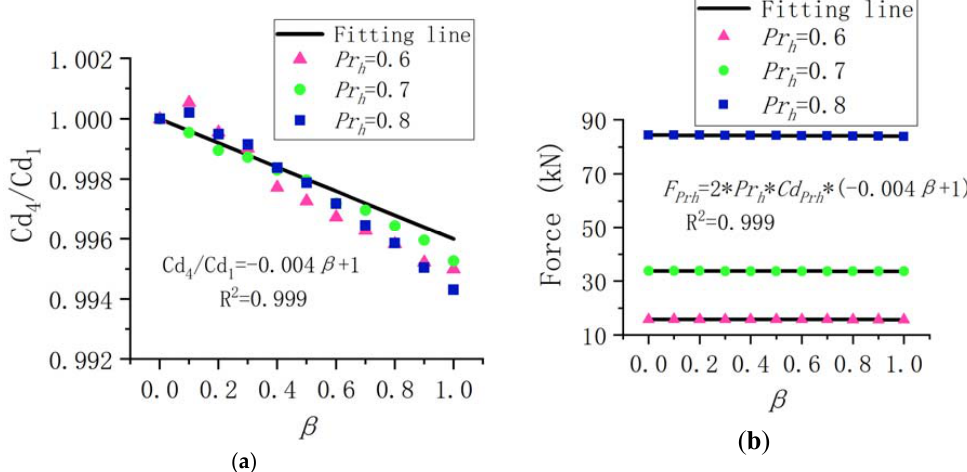
Figure 13. ( a ) Drag coefficient and ( b ) force at different water layer strength ratios (data sources: G1–